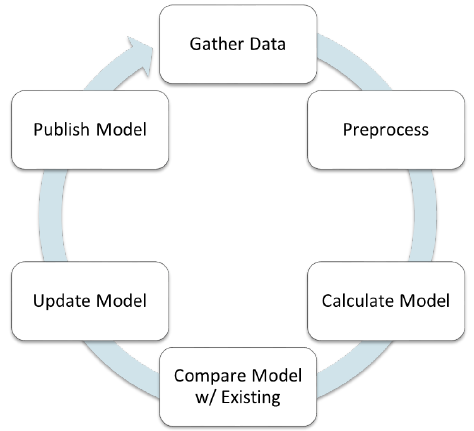
Fig. 2: Machine Learning Model Refinement Loop